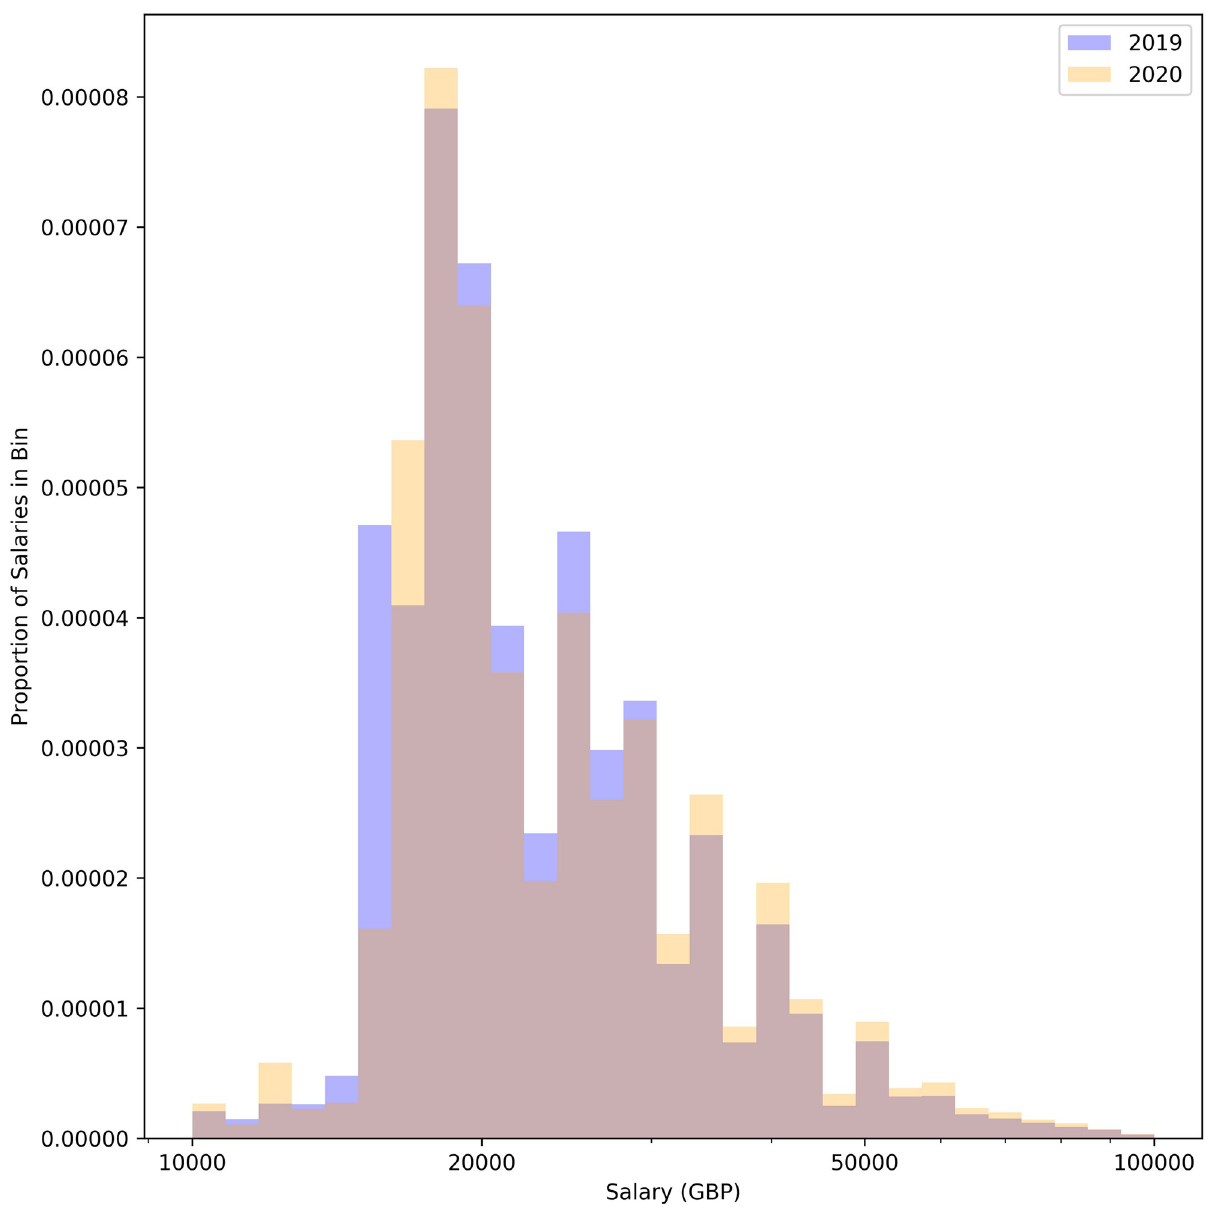
Fig 19. Distribution of annual salaries (obtained from the ‘yearly minimum salary’ field in the JSON returned by the Reed API). 2019 : Mean Salary: 31285 GBP, Median Salary: 25000 GBP. 2020 : Mean Salary: 31645 GBP, Median Salary: 25714